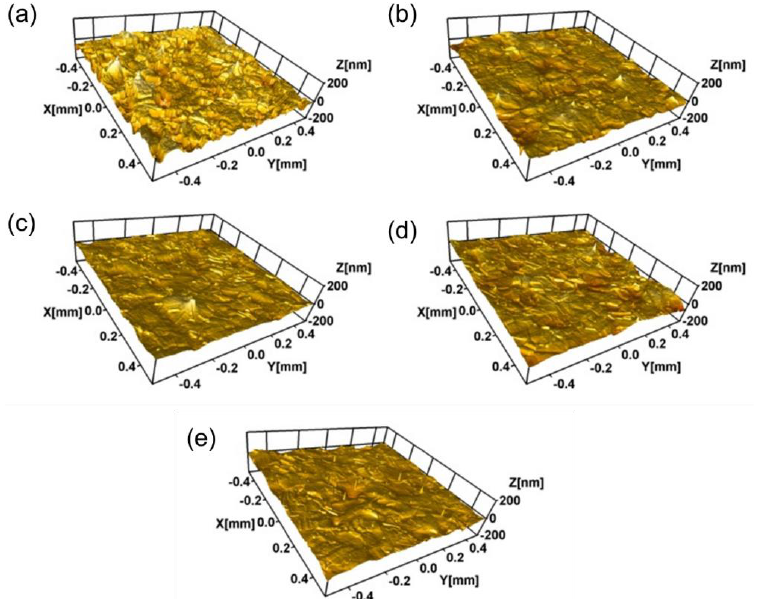
Figure 4. Nano 3D image (optical mode) of 316L stainless steel samples with different Ti ion implantation doses: ( a ) un-implanted; ( b ) 3.0 × 10 16 ions/cm 2 ; ( c ) 1.0 × 10 17 ions/cm 2 ; ( d ) 1.0 × 10 18 ions/cm 2 , and ( e ) 1.7 × 10 18 ions/cm 2 .